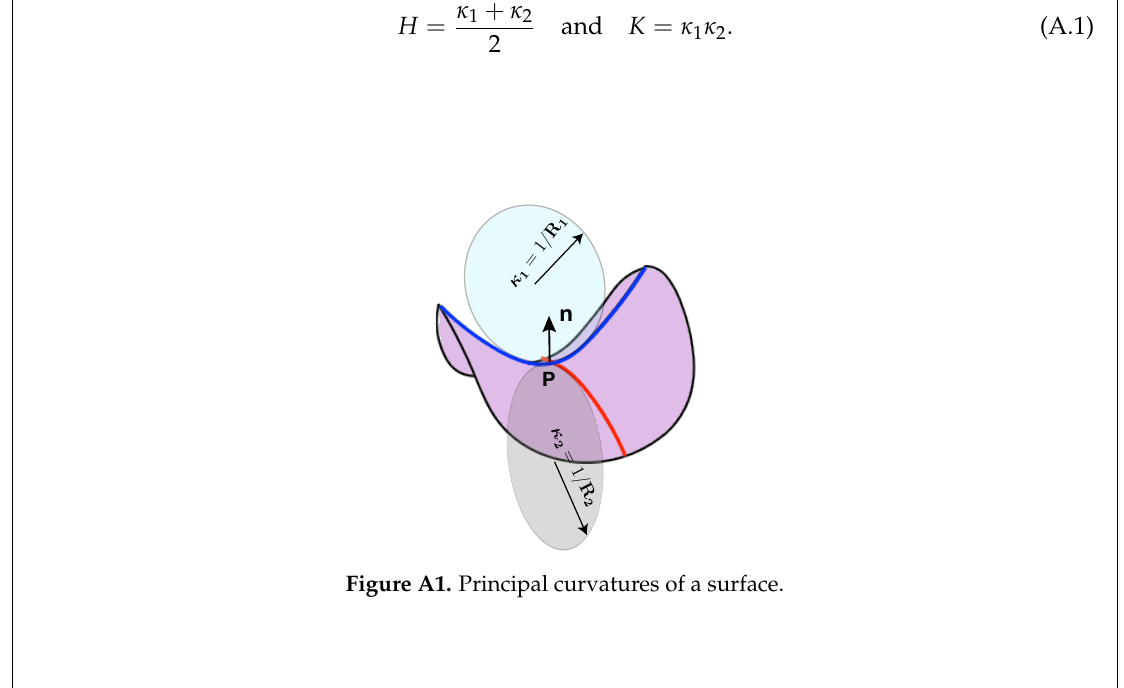
Figure A1. Principal curvatures of a